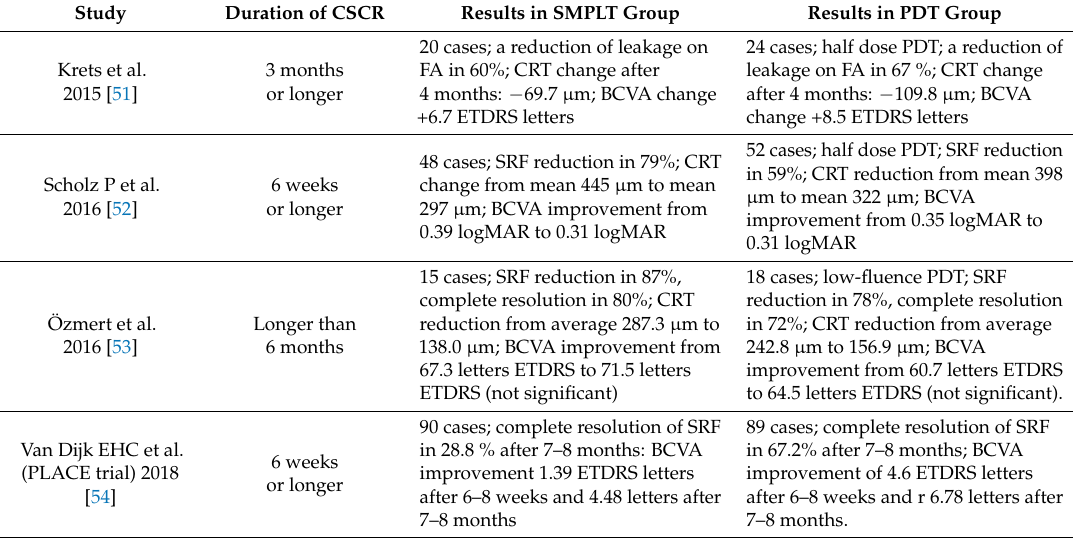
Table 2. Studies comparing the results of treatment by SMPLT or photodynamic therapy (PDT) in chronic CSCR. CSCR: central serous chorioretinopathy, CRT: central retinal thickness, SRF: subretinal fluid, BCVA: best corrected visual acuity, FA: fluorescein angiography, ETDRS: Early Treatment